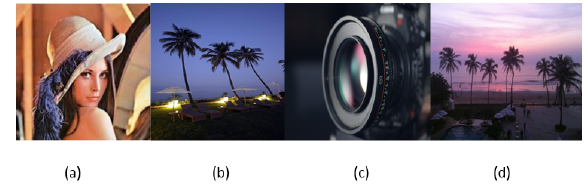
Figure 8. Encrypted image of Lena - size 174 KB